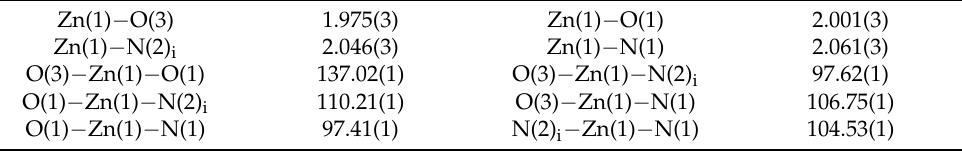
Table 1. Bond lengths (Å) and angles ( ◦ ) around Zn(II) ion 1 .